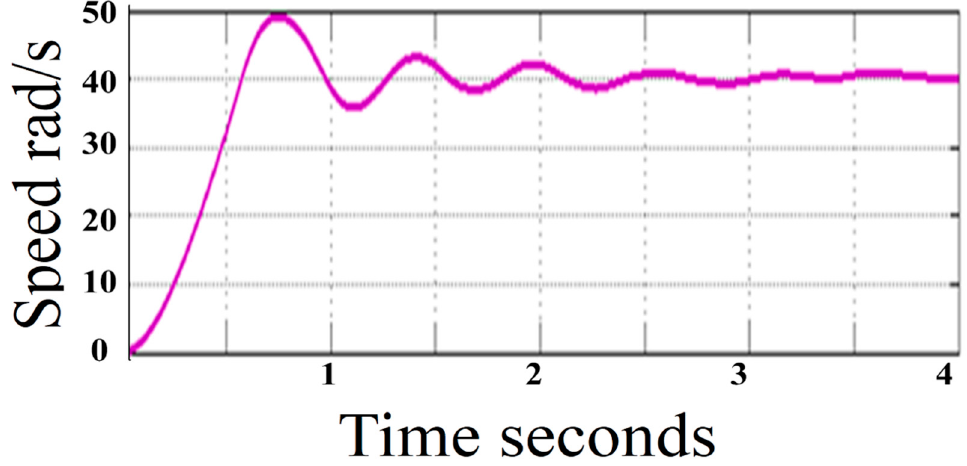
Figure 20. Simulation of the best result obtained in the experimentation with GT2FDE with a noise of 0.9 in the FLC.